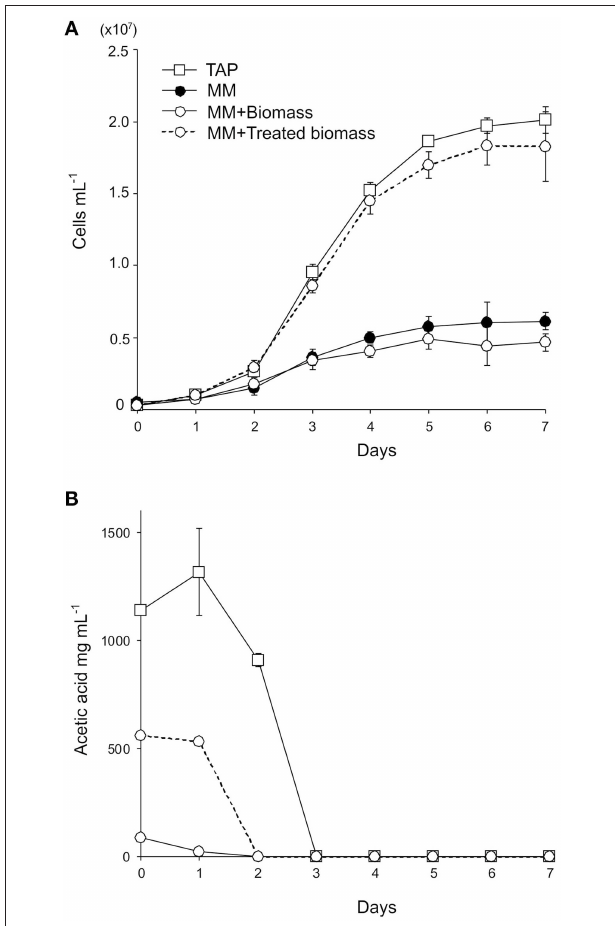
FIGURE 1 | Heterotrophic cultivation of C. reinhardtii using wheat straw biomass. (A) Growth curves of the wild-type strain in enriched media (TAP media, square symbols with a solid line), minimal medium (MM, filled circles with a solid line), MM containing 15g L − 1 wheat straw biomass (MM + Biomass, open circles with a solid line), and MM containing 15g L − 1 alkaline-treated wheat straw biomass (MM + Treated biomass, open circles with a dotted line). (B) Acetate contents in the wild-type C. reinhardtii cultures in TAP, MM + Biomass, and MM + Treated biomass. Three independent cultures were analyzed for each conditions. Average values and standard deviations are